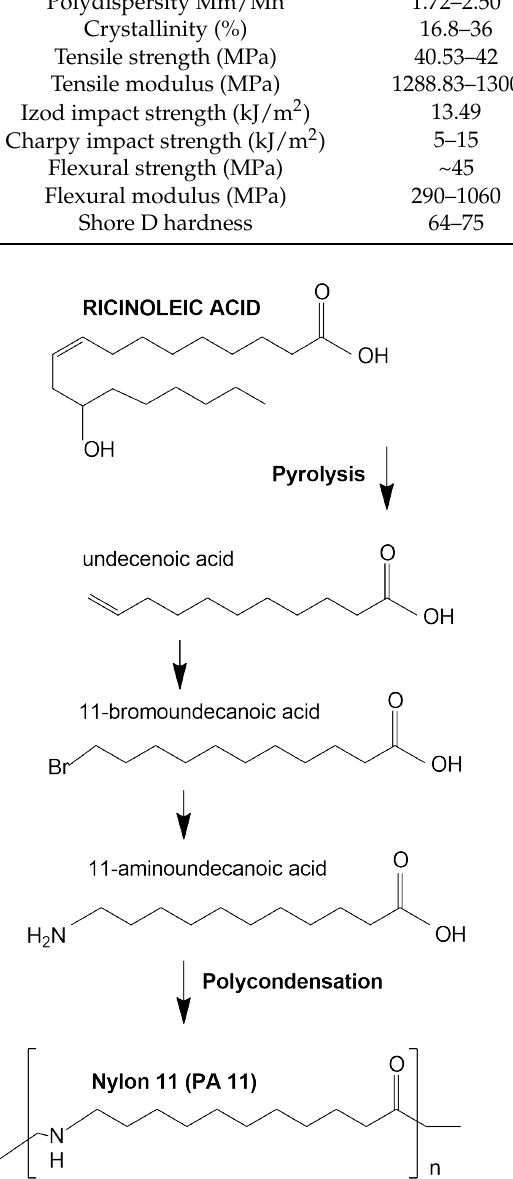
Figure 2. The reaction diagram for obtaining polyamide 11 from castor acid.